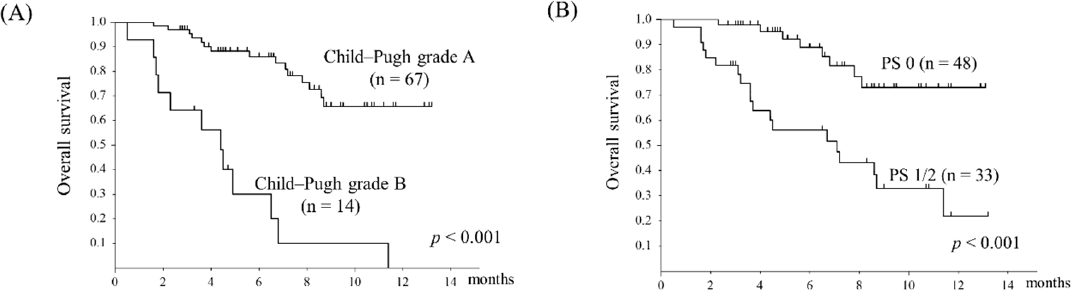
Figure 2. Overall survival stratified by ( A ) Child–Pugh grade and ( B ) performance status. ( A ) Kaplan– Meier curves for Child–Pugh grade A and Child–Pugh grade B. There was a significant difference in OS between the two groups ( p < 0.001). ( B ) Kaplan–Meier curves for performance status 0 and performance status 1/2. There was a significant difference in OS between the two groups ( p < 0.001).